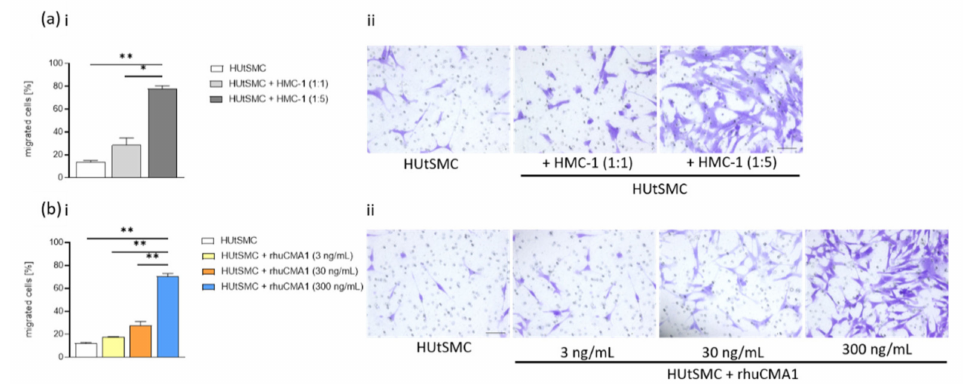
Figure 3. HMC-1 and rhuCMA1 elevate HUtSMC migration. The number of migrated HUtSMC cells cocultured with HMC-1 cells ( a ( i )) at different cell-to-cell ratios (HUtSMC:HMC-1 ratio 1:1 and 1:5) or stimulated with rhuCMA1 ( b ( i )) at different concentrations (3 ng/mL, 30 ng/mL, 300 ng/mL) at 24 h. Representative images are shown in (( a ( ii ), b ( ii )), scale bar 200 µ m). Results are presented as mean with SEM. Statistical analysis was performed using one-way ANOVA (* p < 0.05, ** p < 0.01).